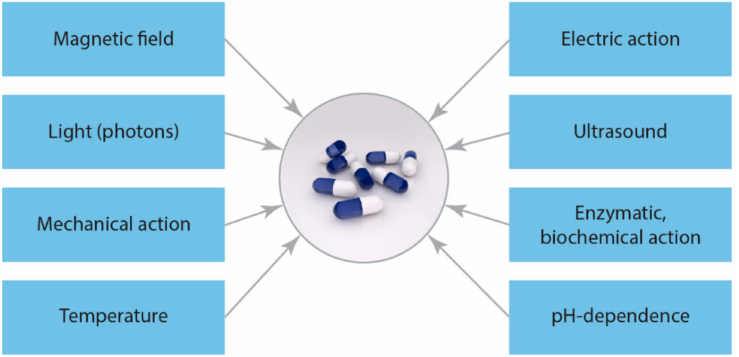
Figure 5. Smart release stimuli (single/dual/multi) for advanced drug delivery via